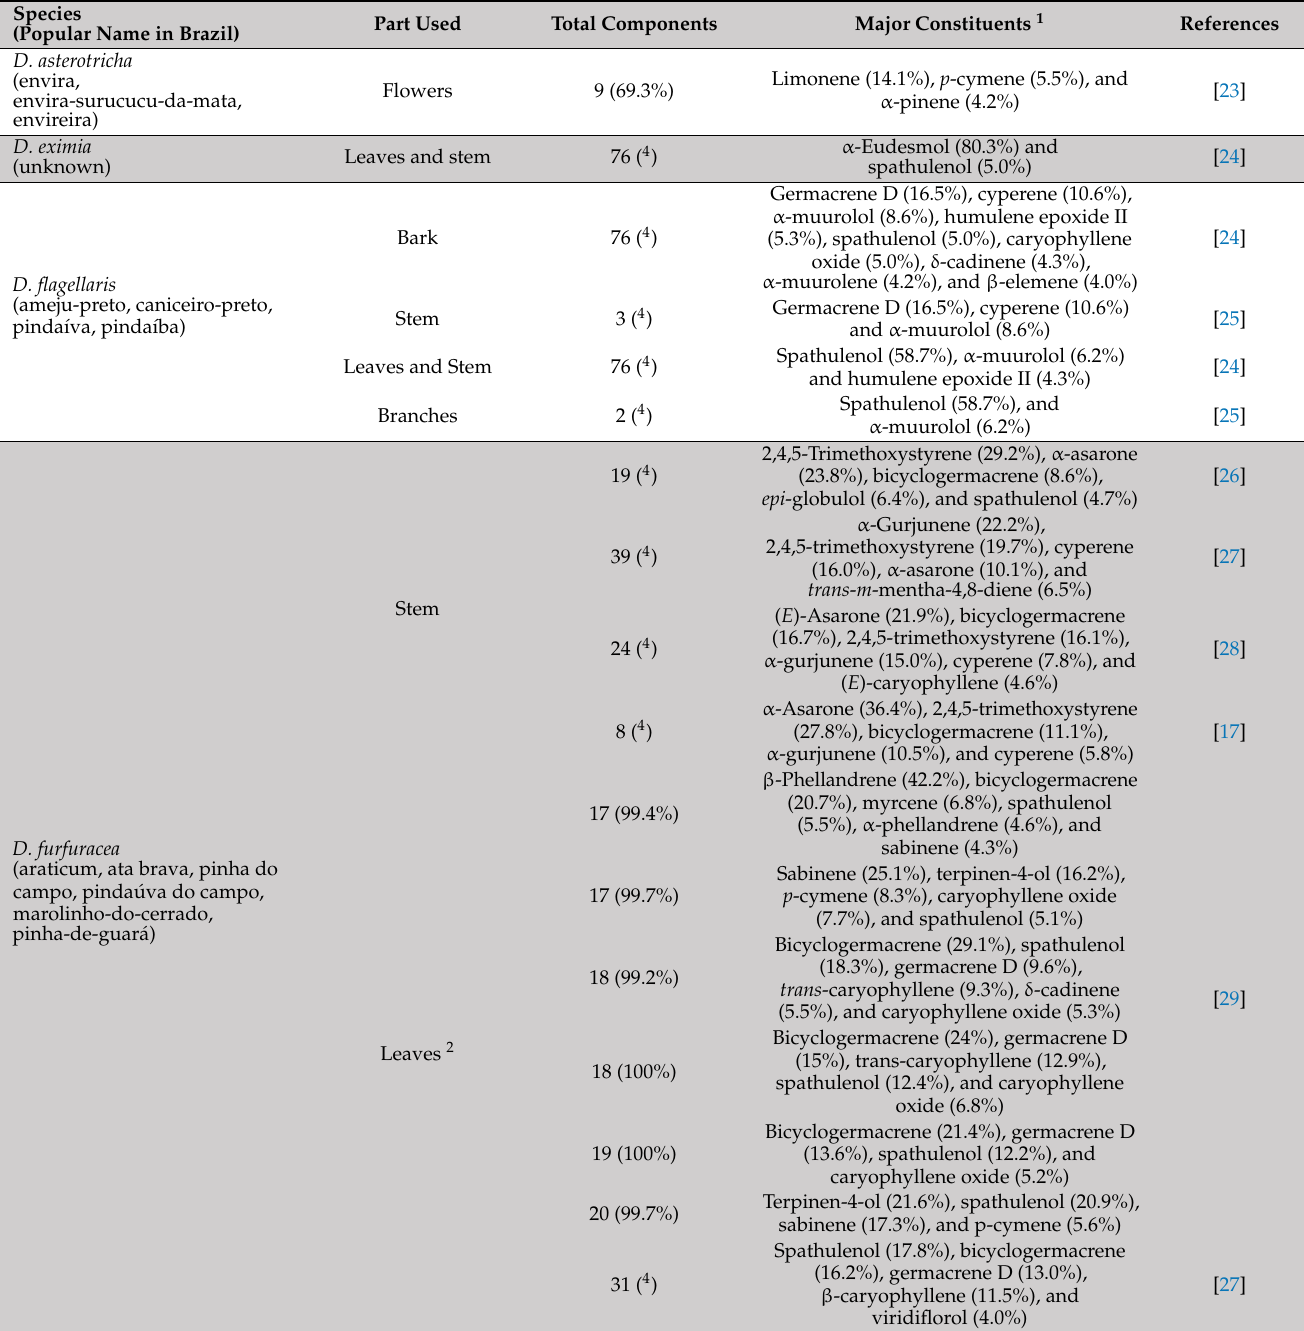
Table 2 lists the main chemical constituents of EOs of Duguetia species. In total, the chemical composition of 56 constituents found in EOs from 12 species of this genus has been reported. These were D. asterotricha (Diels) R. E. Fries, D. eximia Diels, D. flagellaris Huber, D. furfuracea (A. St.-Hil.) Benth. & Hook. f., D. gardneriana Mart., D. glabriuscula (R. E. Fries) R. E. Fries, D. lanceolate A.St.-Hil., D. moricandiana Mart., D. pycnastera Sandwith, D. quitarensis Benth., D. riparia Huber, and D. trunciflora Maas. Figure 1 shows the structures of the major compounds identified in the EOs of these species. Table 2. Main chemical constituents of Duguetia species